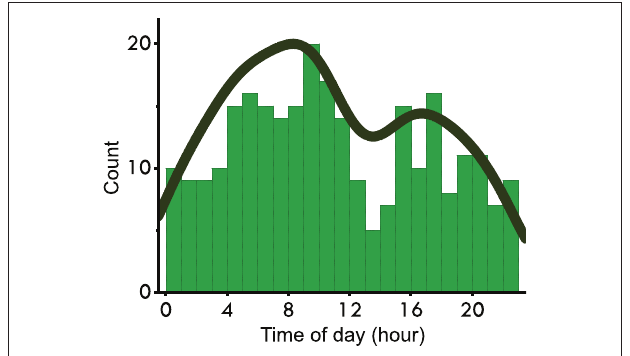
FIGURE 2 | Distribution of time-of-day of seizure occurrences in the EPILEPSIAE scalp-EEG